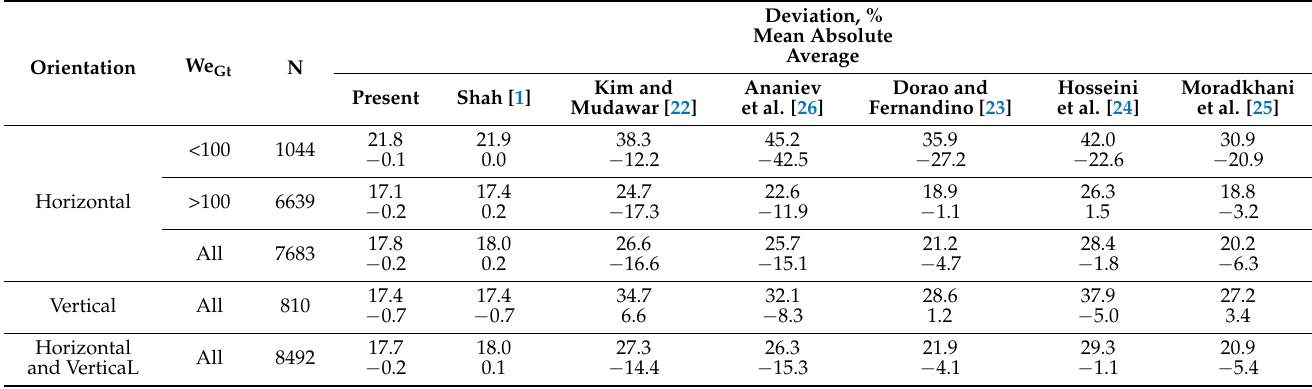
Table 3. Results for the entire database, deviations of various